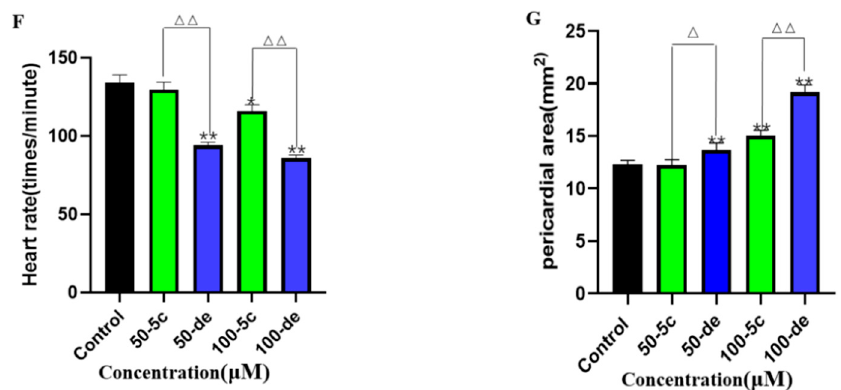
Figure 11. E ff ects of compound 5c and donepezil on the heart rate and pericardial cavity area. The 4 hpf zebrafish embryos were exposed to compound 5c and donepezil separately at 50 and 100 µ M until 96 hpf. Representative image of e ff ects of di ff erent compound 5c and donepezil exposure groups on the pericardial cavity in zebrafish embryos: control ( A ), compound 5c 50 µ M ( B ), compound 5c 100 µ M ( C ), donepezil 50 µ M ( D ), donepezil 50 µ M ( E ), a histogram shows the di ff erence between compound 5c and donepezil in heart rate in zebrafish embryos ( F ), pericardial area of each treatment quantified ( G ). * p < 0.05, ** p < 0.01 vs. control group; △ p < 0.05; △△ p < 0.01 compound 5c group vs. donepezil group.